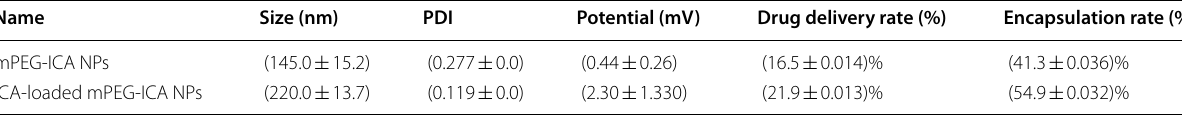
Table 1 Comparison of mPEG-ICA NPs and ICA-loaded